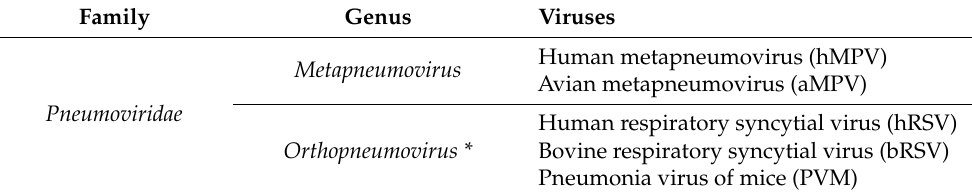
Table 1. Phylogeny of Pneumoviridae .